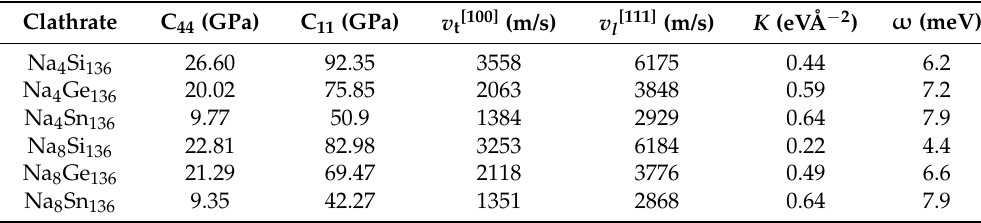
Table 2. Elastic Properties of Na x M 136 ( x = 4, 8; M = Si, Ge,